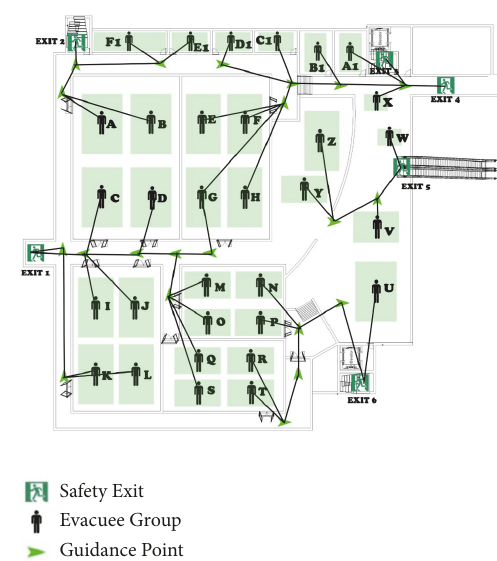
Figure 3: Partial Least Square (PLS) SEM diagram.